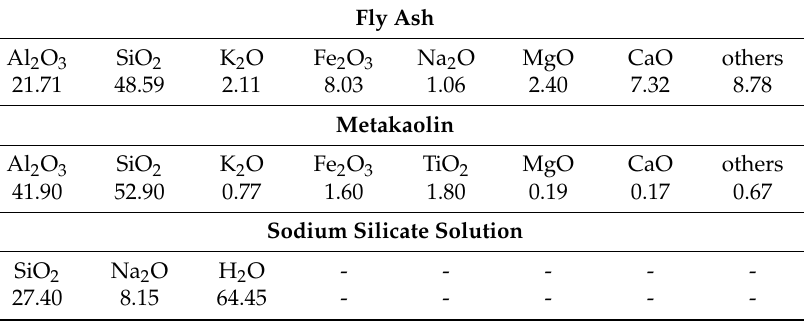
Table 1. Chemical composition (wt %) of the fly ash, metakaolin, and sodium silicate solution used in this paper.